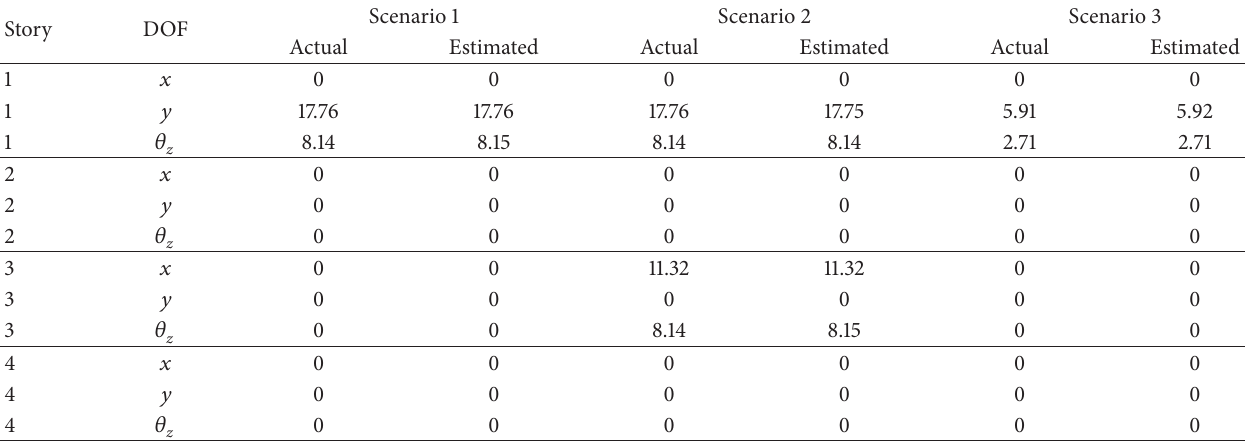
Table 8: The obtained results of damage detection for the benchmark structure. Story